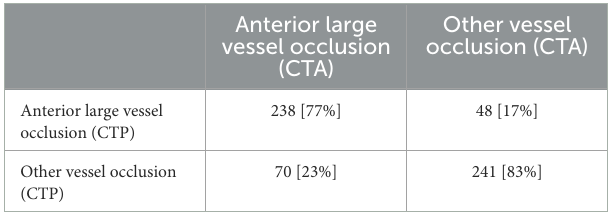
TABLE 5 The confusion matrix for the annotated vessel occlusion locations from CT angiography (CTA) and the indicated vessel occlusion locations from CT perfusion (CTP) if we dichotomize the vessel occlusion locations into anterior large vessel occlusions and other vessel